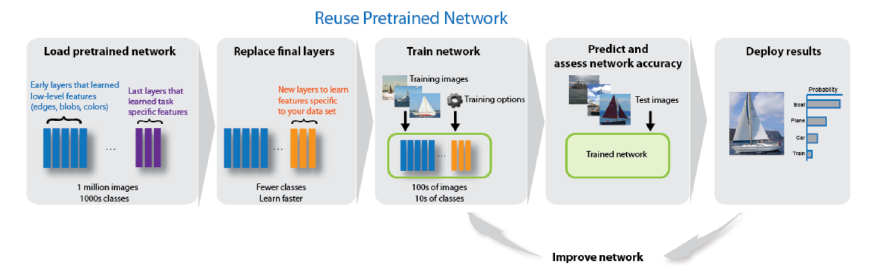
Figure 4. The scheme of Pretrained DLNN transfer learning